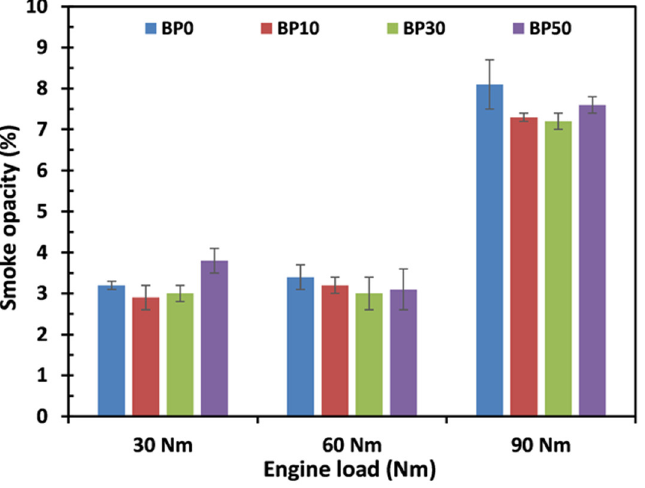
Figure 11. Smoke opacity for all test fuels according to various engine